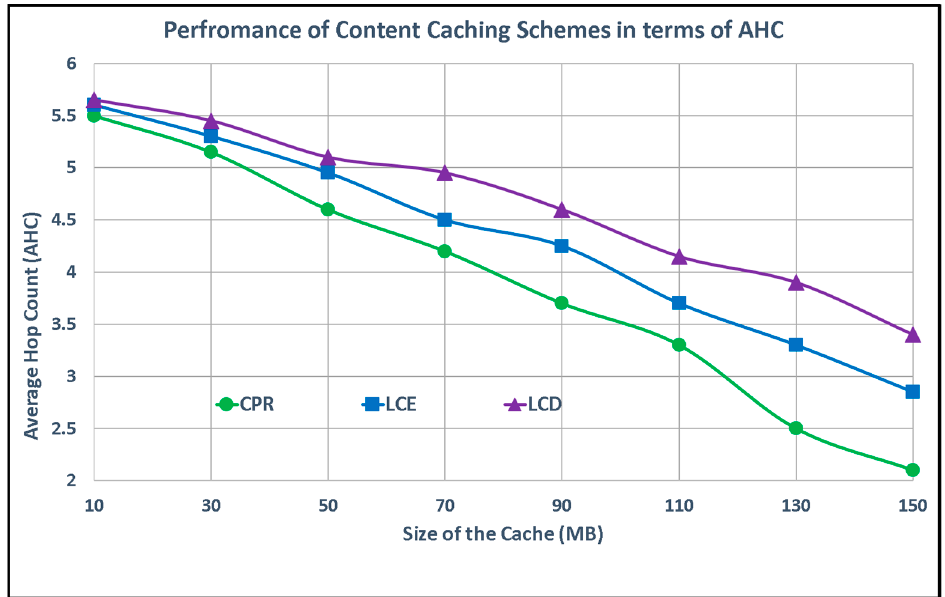
Figure 2. Average hop count against increasing cache sizes.